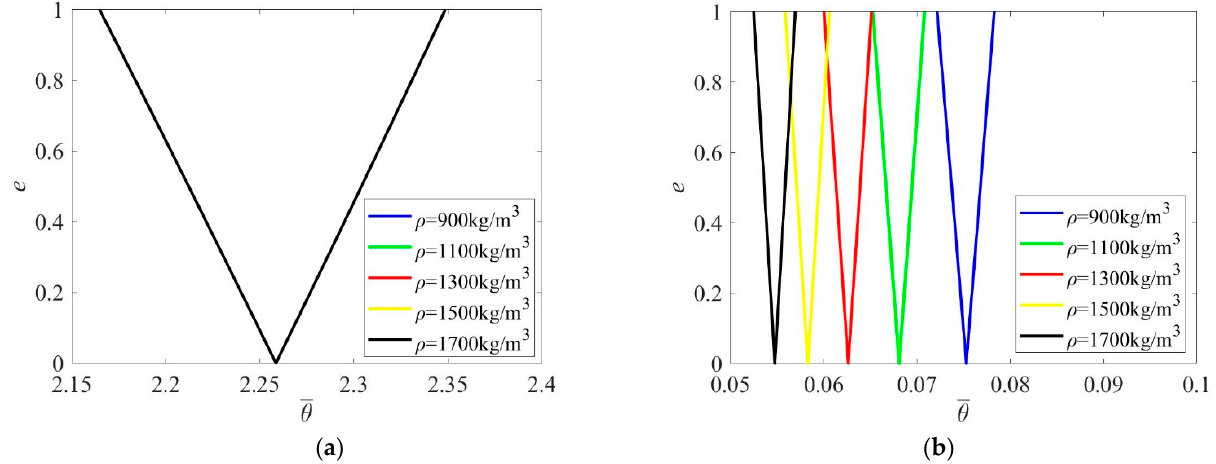
√ (cid:112) E ρ / E ; ( b ) θ = θ L /